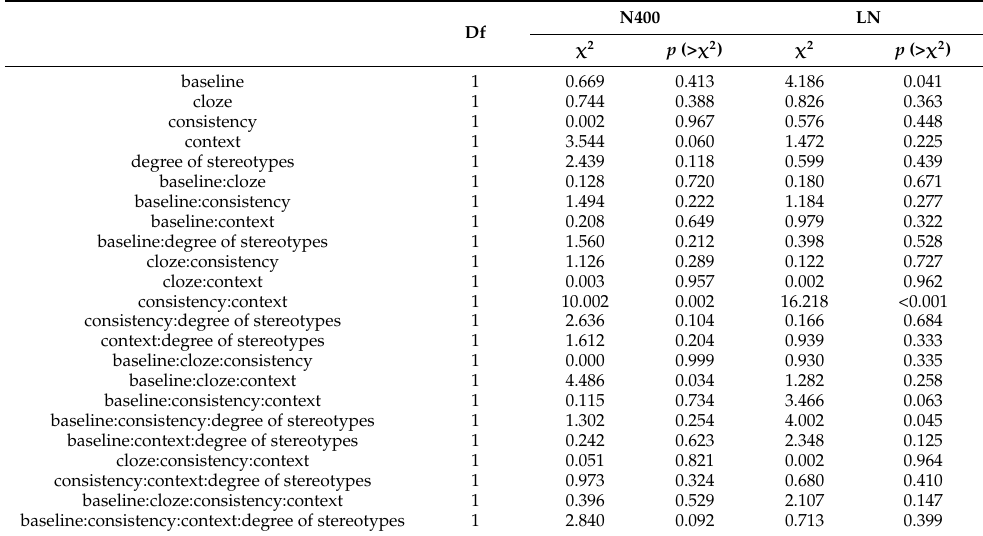
Table 4. Analysis of deviance (Type II Wald chi-square tests) for the N400 (350–600 ms) and LN (800–1000 ms) time